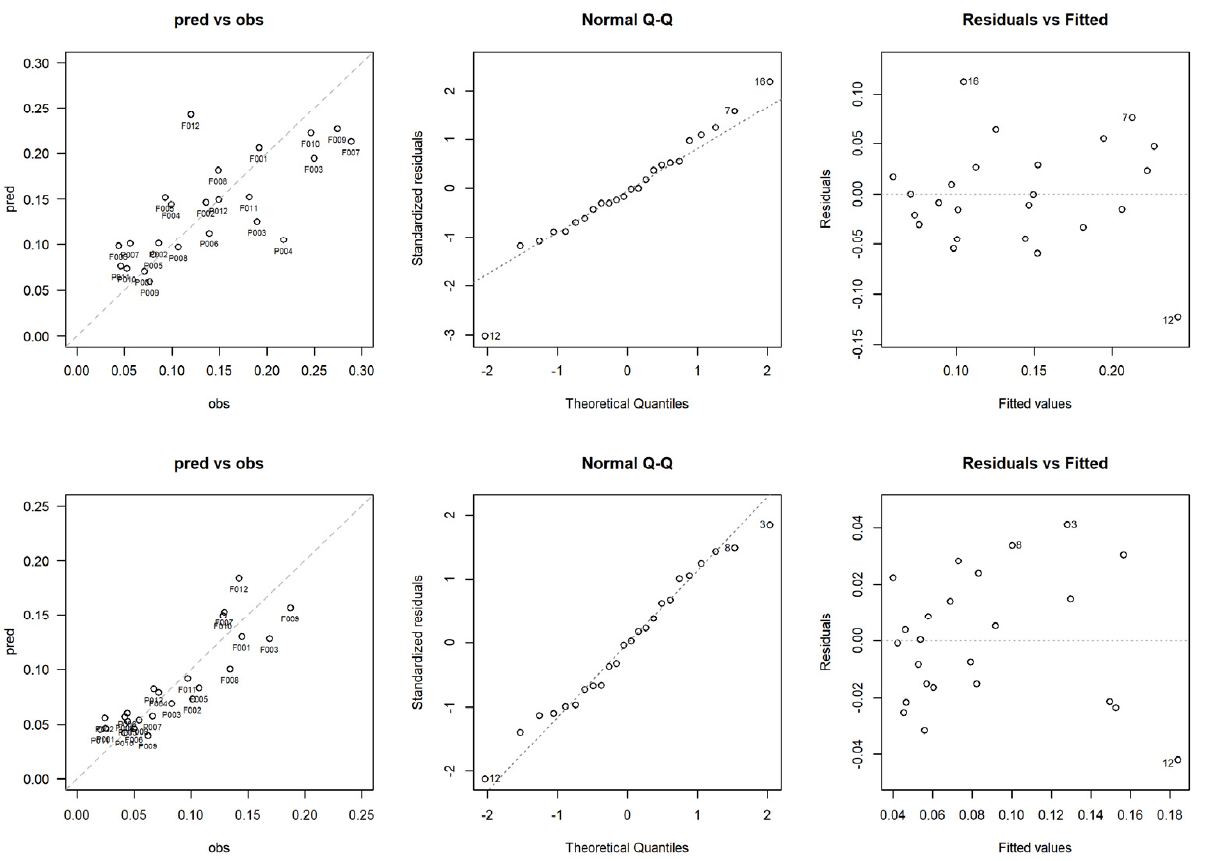
Figure 5 shows scatter plots of the observed TLS-based versus the ALS-based predicted variables, together with the residual analysis, for both lower (LU) and upper (UU) under- story. LU residuals are relatively uniformly distributed, except for two extreme values. UU residuals are much closer to the zero line but display a possible unexplained curvature.